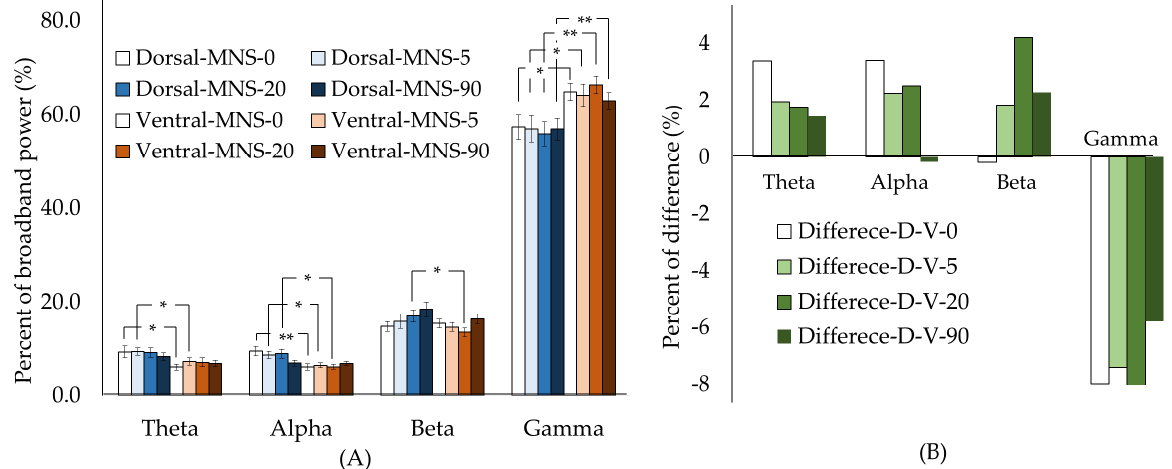
Figure 3. Comparison of each frequency band between dorsal and ventral STN under different frequencies of MNS and no MNS. ( A ) The moderately significant differences between dorsal and ventral STN were in the gamma oscillation band with MNS − 5 and MNS − 90, and in the alpha oscillation band with no MNS. ( B ) The percent differences in each frequency band between dorsal and ventral STN under different frequency MNS and no MNS show the largest difference in the theta and alpha oscillation bands, while MNS − 20 shows the largest difference in the beta and gamma oscillation bands. Single asterisk (*) indicates a significant difference with p value < 0.05. Double asterisks (**) indicate a moderately significant difference between dorsal and ventral STN with p value < 0.01. MNS − 0 indicates no